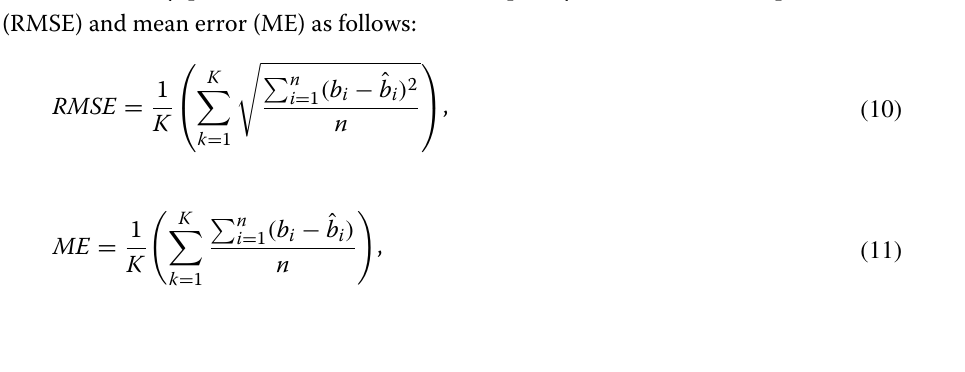
Position in form 2